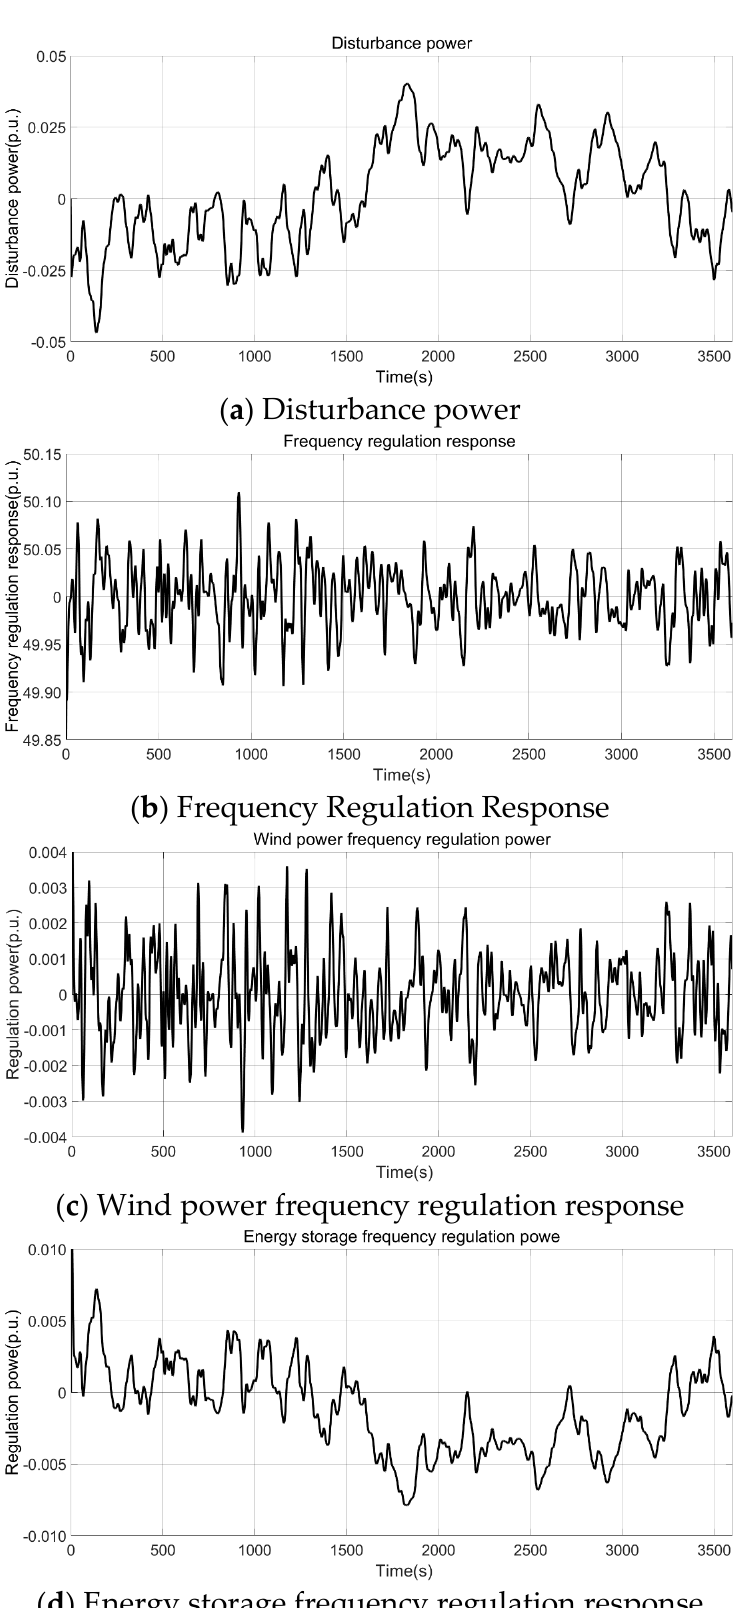
Figure 14. Control results of the proposed control strategy.